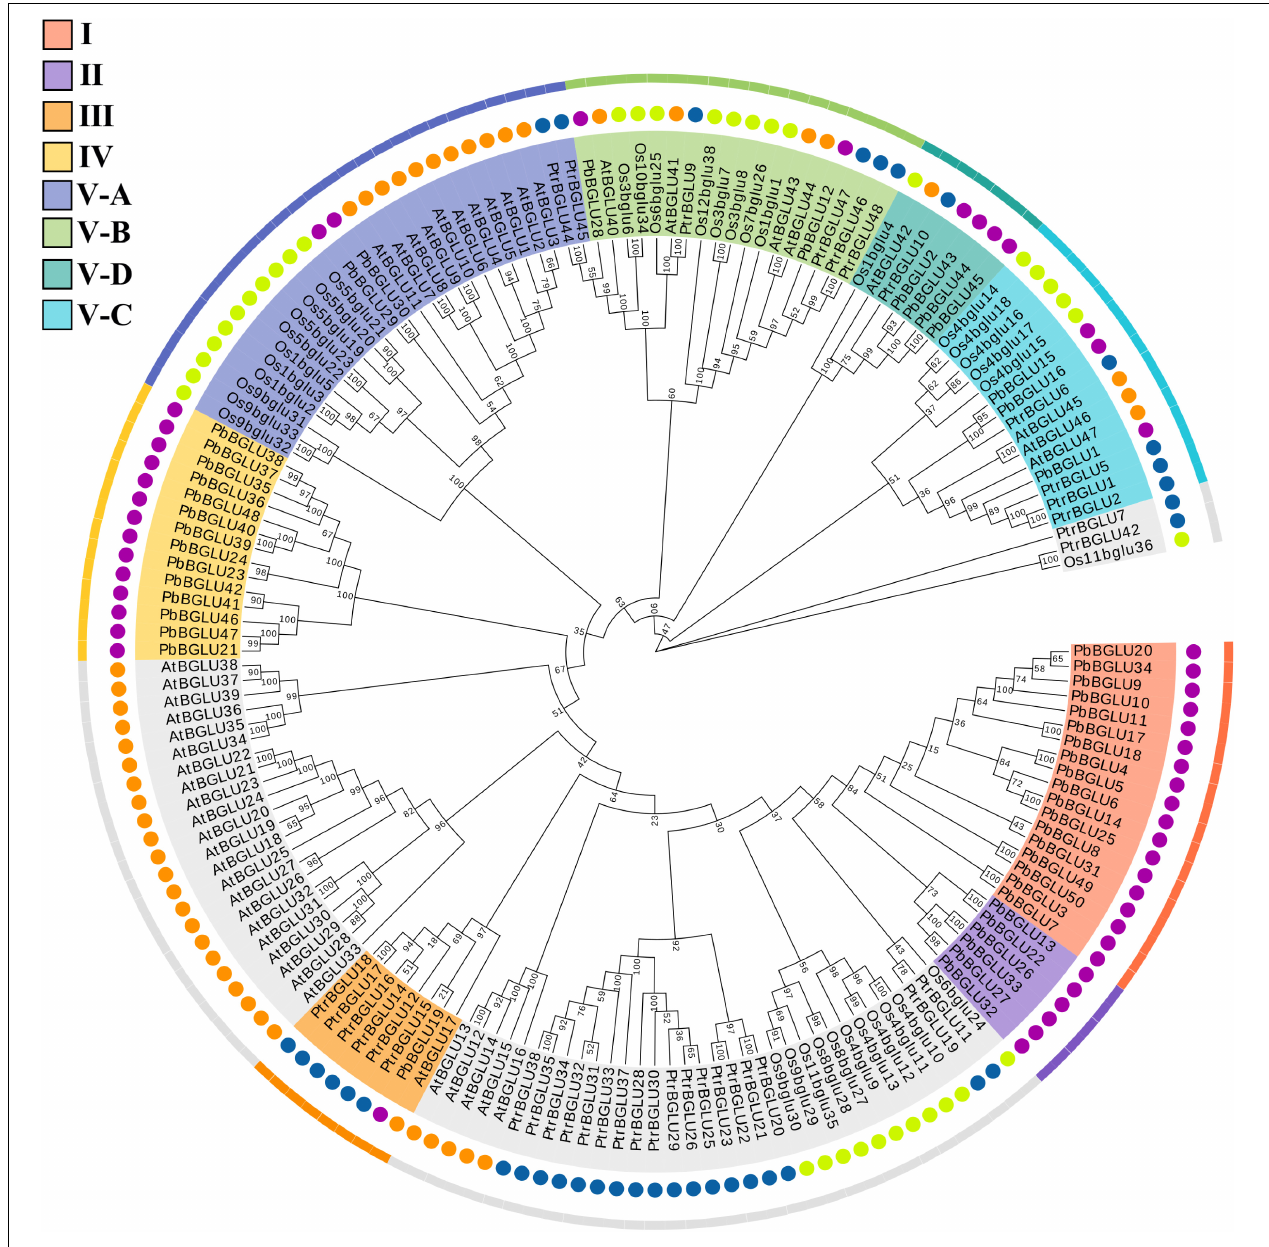
FIGURE 2 | Phylogenetic analysis of BGLU s from Pyrus bretschneideri , Arabidopsis thaliana , Oryza sative, and poplar . The neighbor-joining (NJ) method was used to construct the phylogenetic tree. Pb: Pyrus bretschneideri ; Os: Oryza sative ; Ptr: Poplar L.; At: Arabidopsis thaliana